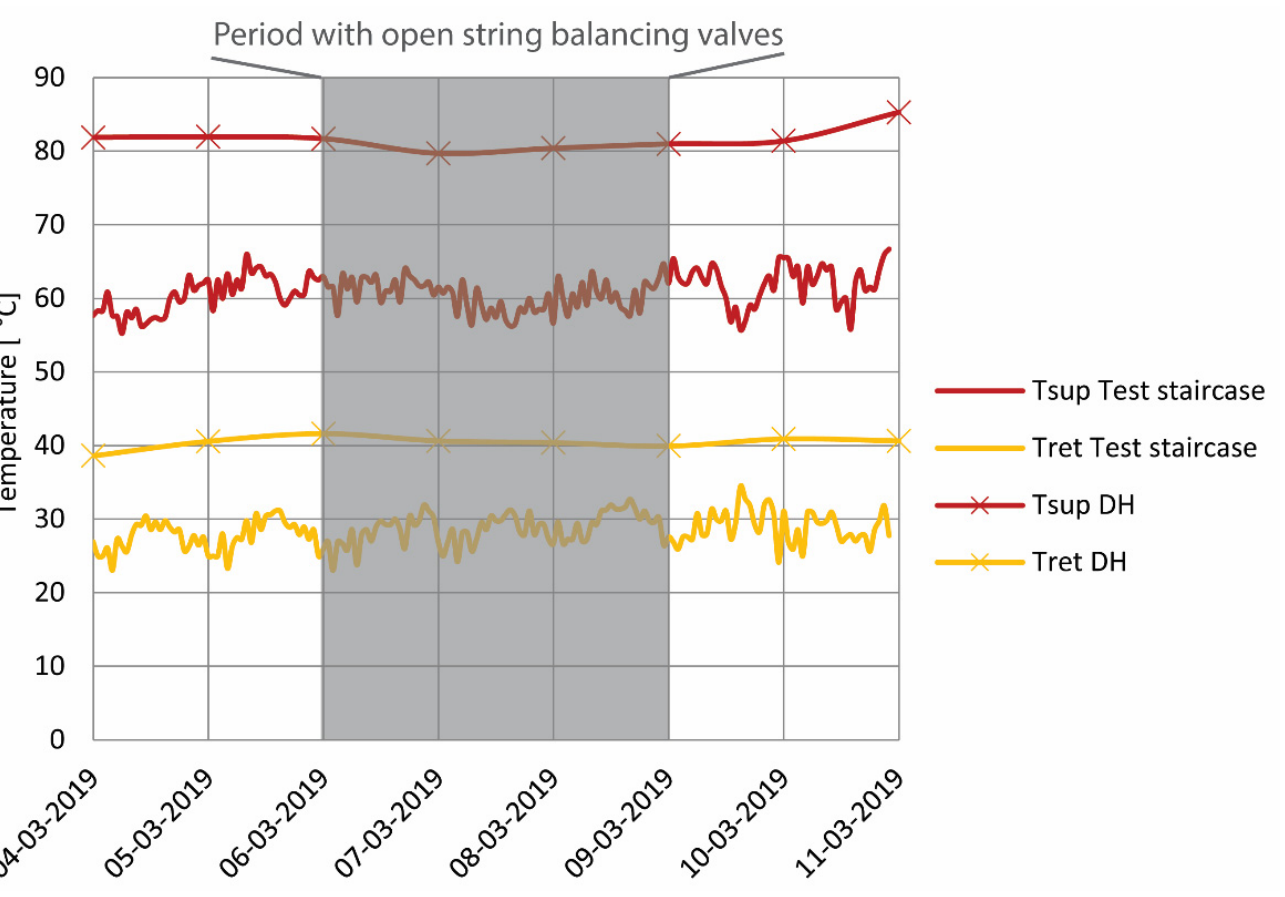
Figure 10. Supply and return temperatures in the space heating system of the test staircase and from the main district heating meter during a period where string balancing valves are opened up.